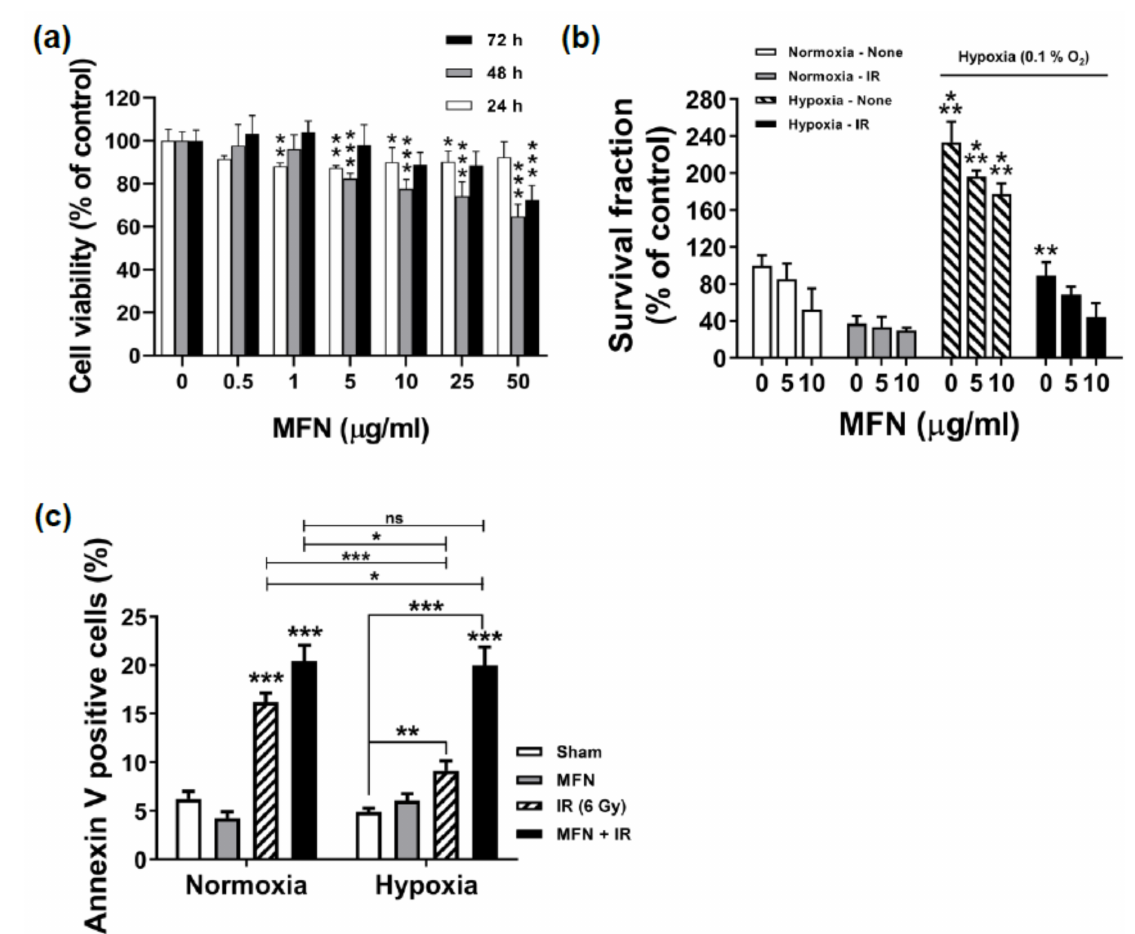
Figure 2. Effects of MnFe 2 O 4 nanoparticles (MFN) on the viability and radiosensitization of murine hepatoma Hepa1-6 cells. ( a ) Concentration- and time-dependent cytotoxicity of MFN. Cell viability was determined using the CCK-8 assay. ( b ) Radiosensitizing effect of MFN under hypoxia. Clonogenic survival assays were performed as described in the Materials and Methods. Hepa1-6 cells were pre-incubated with 5 or 10 µ g/mL of MFN for 3 h, and then subjected to a 6-Gy irradiation under normoxic or hypoxic conditions. ( c ) Promotion of apoptosis by MFN under hypoxia. Flow cytometry of Annexin V-stained cells was performed for the analysis of apoptosis. The values represent the mean ± standard deviation (SD); * p < 0.05; ** p < 0.01; *** p < 0.001; ns, not